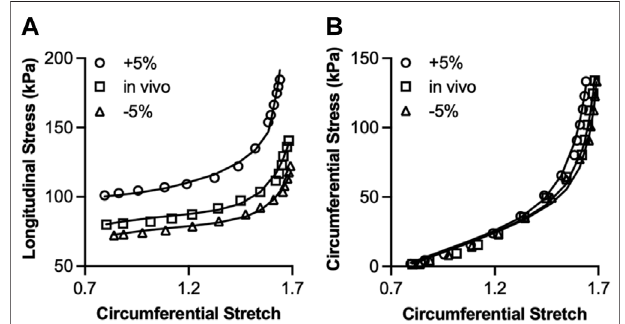
FIGURE 4 | Fitting of a 4- fi ber family model to the longitudinal (A) and circumferential (B) Cauchy stress-stretch curves at three different axial stretches ( in vivo , 5% above and below in vivo ). The equations for the longitudinal and circumferential Cauchy stresses were fi tted to the experimental data under the three axial stretches simultaneously. Best- fi t parameters and coef fi cient of determination, R 2 are given in Supplementary Tables S1 – S3